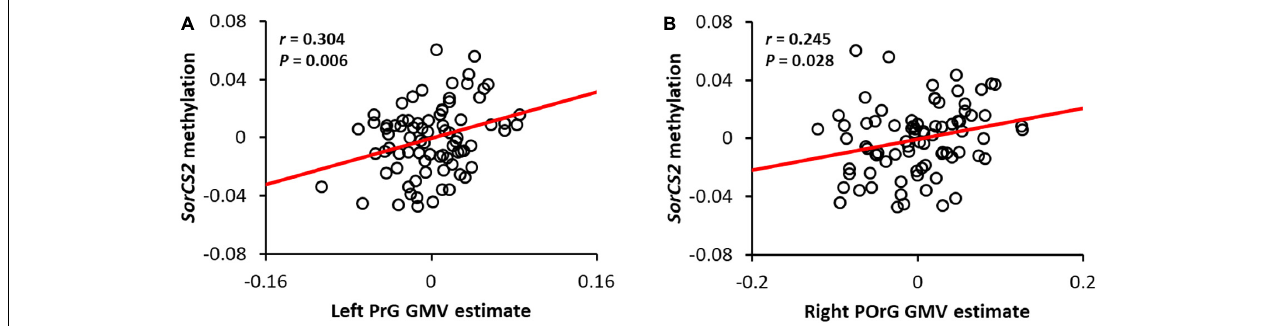
FIGURE 2 | Correlation between SorCS2 methylation and gray matter volume in the left precentral gyrus (A) and the right posterior orbital gyrus (B) . The red line shows the regression line. Adjusted residuals with respective covariates were used as values for methylation and local GMV of SorCS2. Note that the adjusted residuals for each covariate were used as estimates of SorCS2 methylation and local